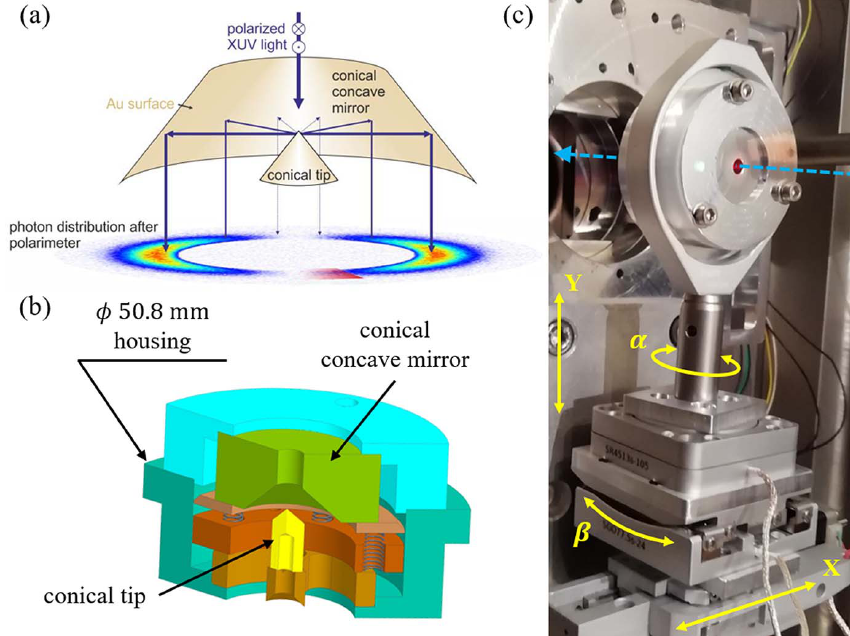
Figure 1 ( a ) Schematic view of the COMIX polarimeter. Due to the cylindrical symmetry, the transmitted intensity distribution depends on the polarization state of the incident beam. ( b ) Mechanical drawing of the COMIX polarimeter prototype, which can be mounted in standard optomechanical stages. ( c ) Four-axis motorized goniometer to precisely align the conical tip apex with respect to the XUV beam. The light blue dashed arrow shows the axis of the XUV beam, directed towards the CCD camera (not